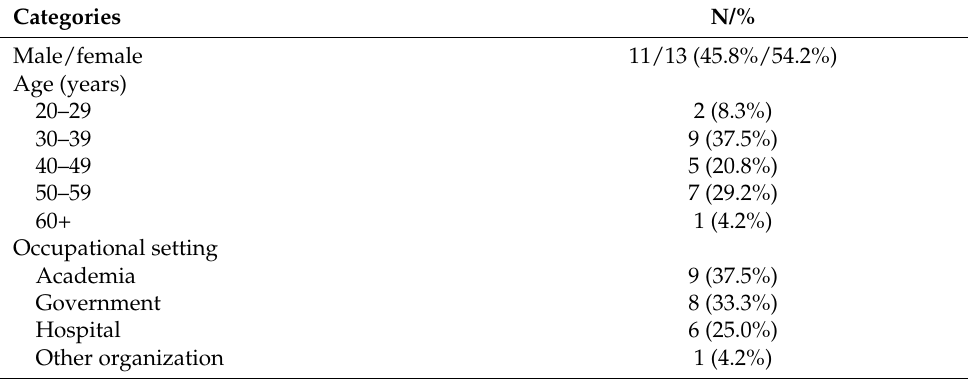
Table 1. Basic characteristics of respondents.